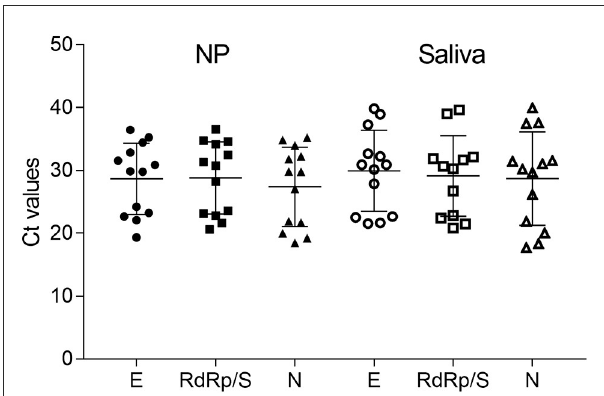
FIGURE2 C t values from paired samples distinct in E , RdRp/S, and N genes for both NP and saliva samples. The graph shows generally higher C t values in saliva samples, but this difference is not